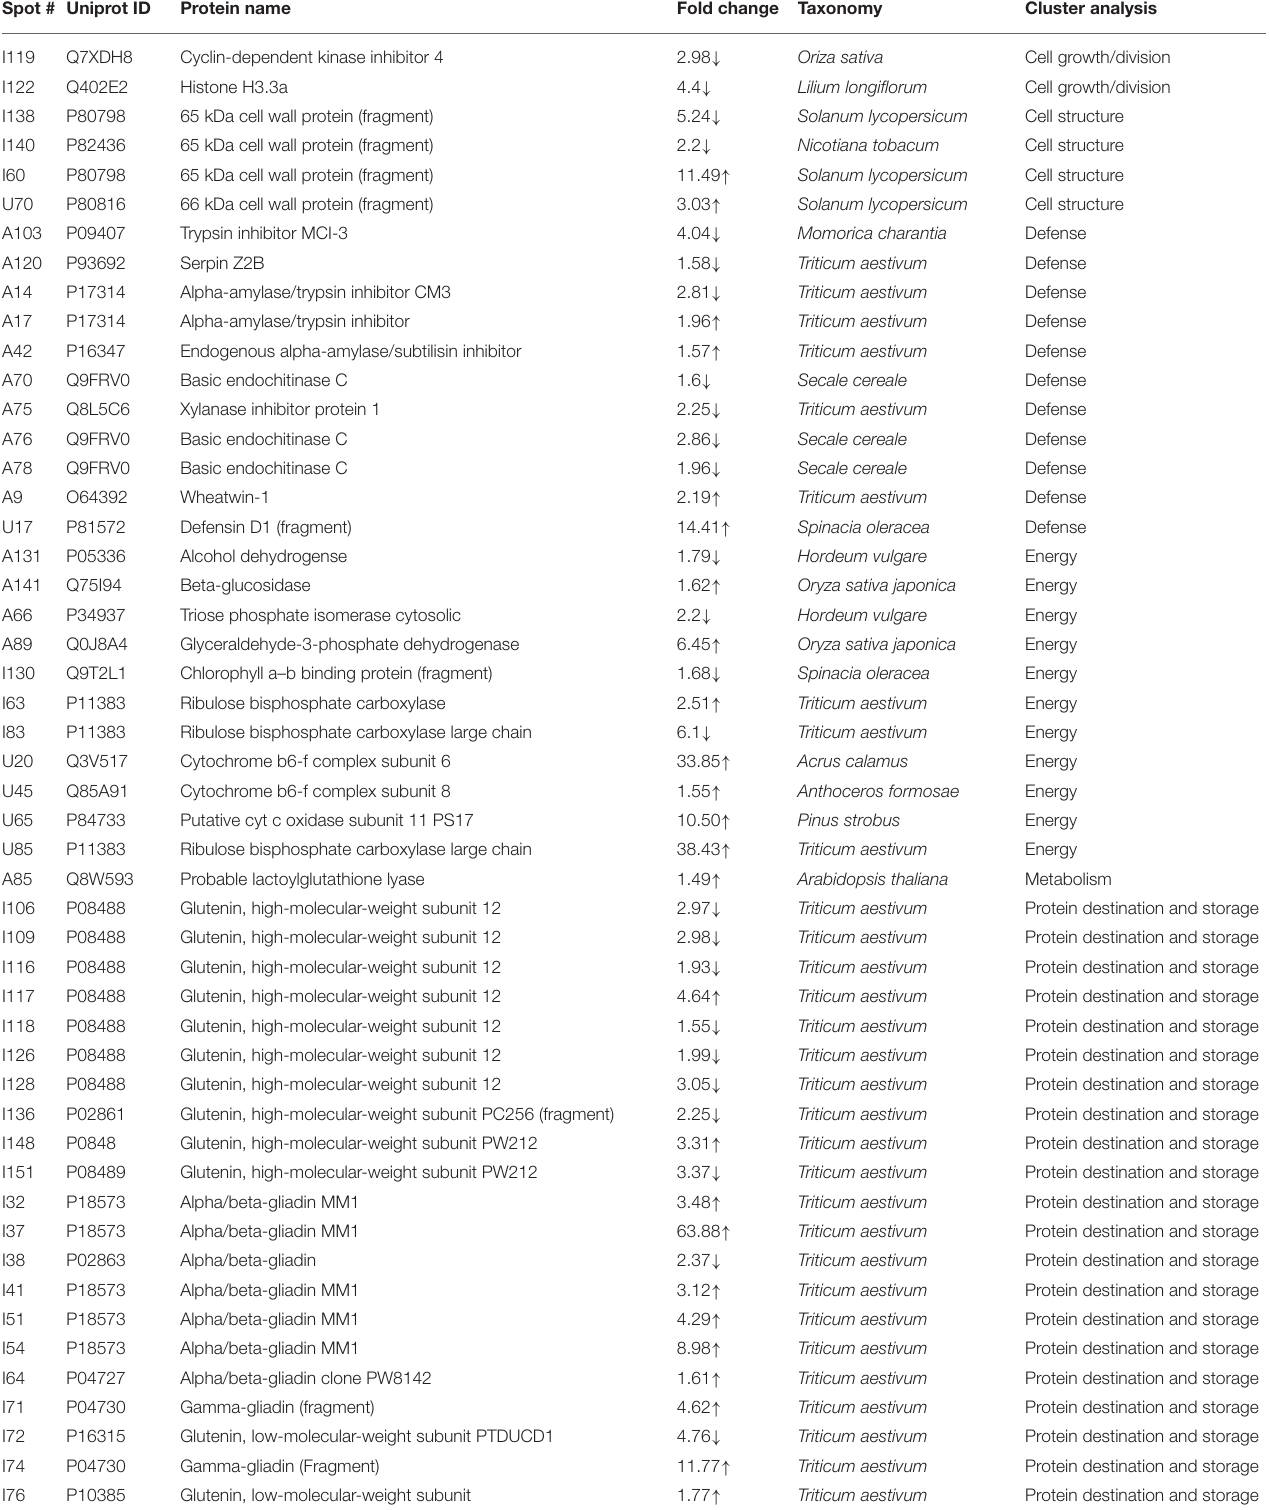
TABLE 1 | List of differentially expressed proteins in mature grains under day heat stress (35 /17 ◦ C vs. 24/17 ◦ C) as analyzed by matrix-assisted laser desorption/ionization time-of-flight mass spectroscopy. Spot # Uniprot